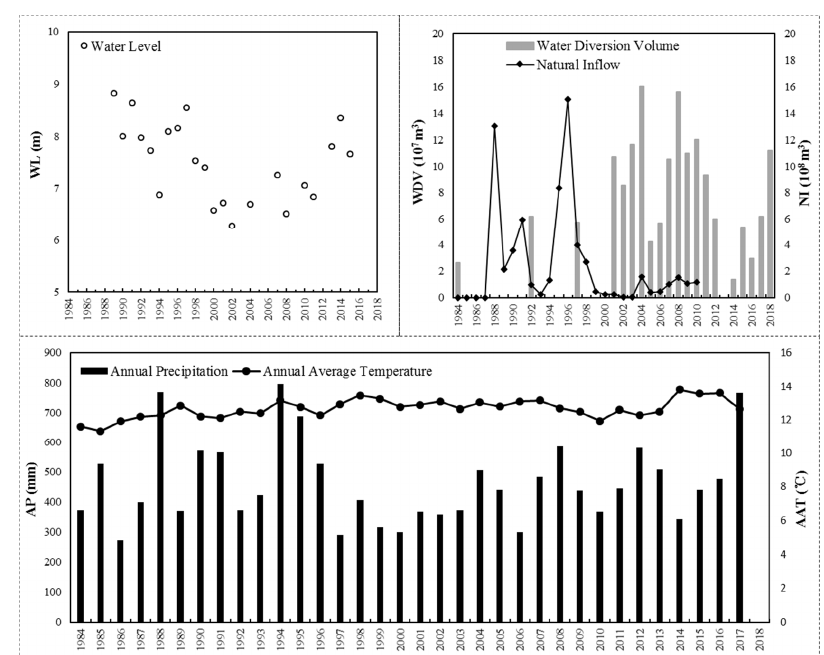
Figure 3. Hydrological and climate data used in this study.